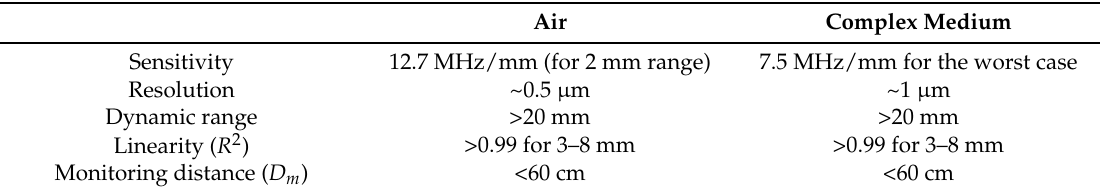
Figure 1. A diagram illustrating the working principle of the sensing system. Table 1. Sensing system properties for the measurements carried out in air and the complex medium consisting of the concrete, the rebar grid, and the concrete cover [40,42].